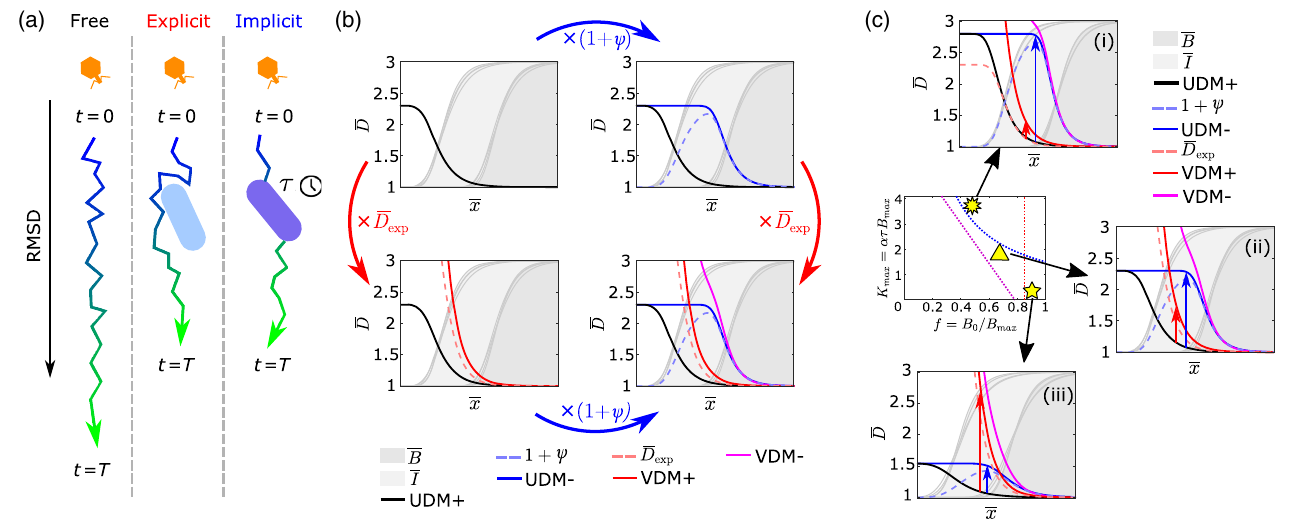
FIG. 4. (a) An illustration of both explicit and implicit effects on phage diffusion. Because of the explicit effect, phage diffusion is hindered by steric interactions with bacterial hosts, while the implicit effect hinders phage diffusion by trapping the virus for a period τ during which it cannot disperse. Color gradients on the phage trajectories indicate the passage of time. RMSD indicates root mean squared displacement. (b) Proxies for the diffusive behavior in each of the model variants plotted as a function of ¯ D the position across the expansion front. The base diffusion coefficient [Eq. (8)] in the UDM þ (black solid line) is modified imp þ either by the term 1 þ ψ (blue arrow and blue dashed line) in the UDM − (blue solid line), which accounts for the now unhindered ¯ D diffusion in the region of infected cells, or by an additional term (red arrow and red dashed line) in the VDM þ (red solid line), exp which accounts for the hindrance due to steric effects. Both modifications occur in the VDM − (magenta line). Faint gray lines indicate the different front profiles from the model variants used to calculate the diffusion coefficient profiles (see Sec. VI). (c) Diffusion profiles for three representative cases are shown, all highlighted in comparison to the semipushed transition lines for the models shown in Fig. 3: (i) high K and low f , where the UDM − and VDM − expansions are pushed; (ii) intermediate f and K , max max where only the VDM − expansion is pushed; (iii) low K and high f , where the VDM þ and VDM − expansions are pushed. Red and max ¯ D blue arrows highlight the shift in from the UDM þ to the VDM þ and UDM − , respectively, at the position where the viral profile is approximately 3 = 4 times its steady